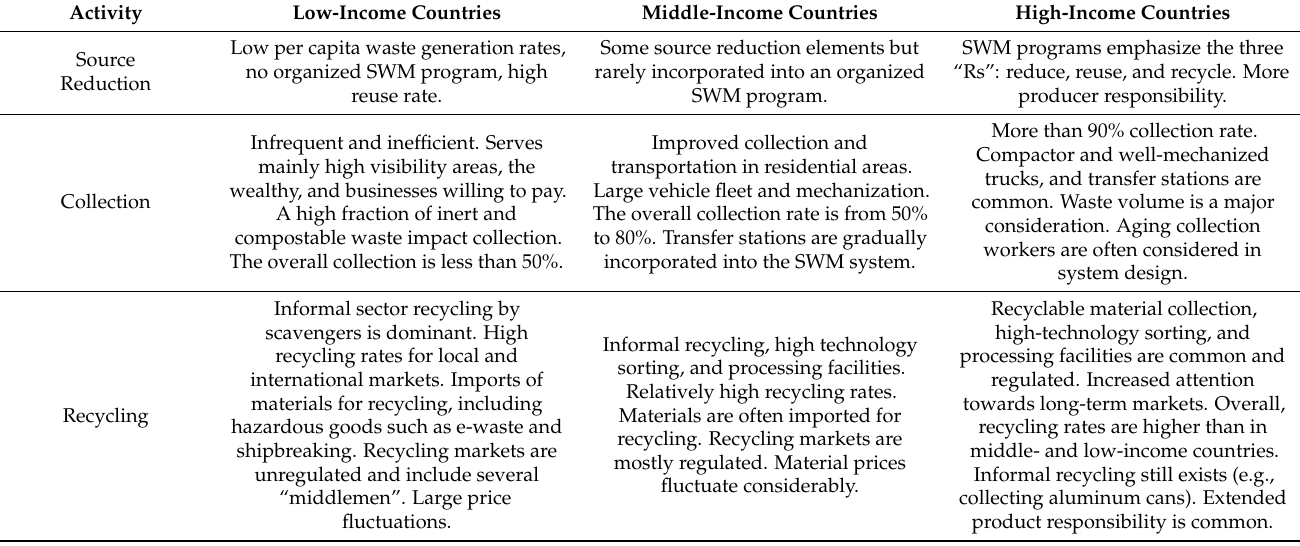
Table 1. Common MSW management practices by country’s level of economic development (adapted from